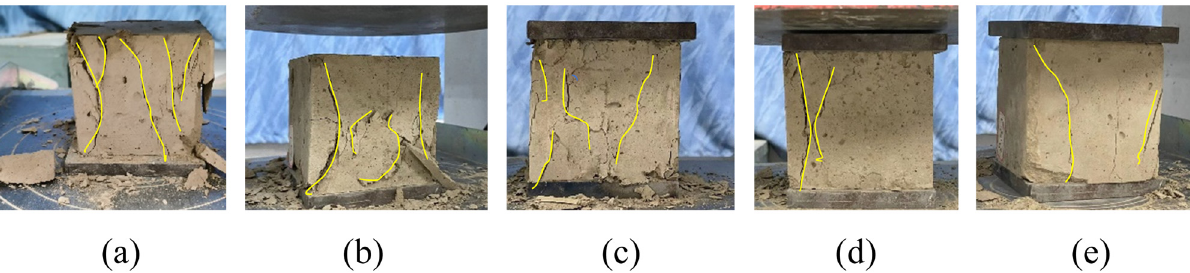
Figure 6: Destruction form of test block before modi fi cation: ( a ) yellow mud and after modifying using ( b ) straw, ( c ) starch, ( d ) cement, and ( e ) epoxy